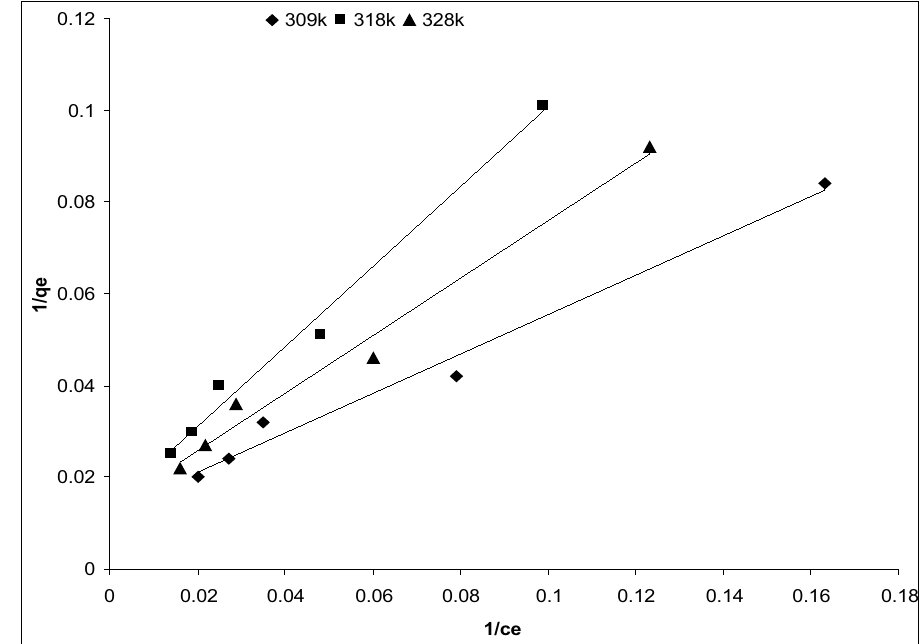
, and initial CR for the sorption of CR by PKC at varying sorbent dosages (g). R